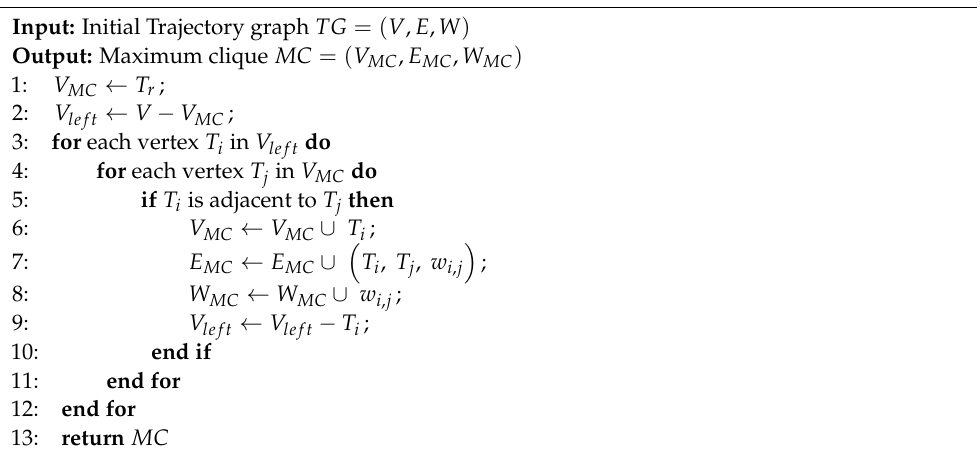
Algorithm 2. Search for Maximum Clique